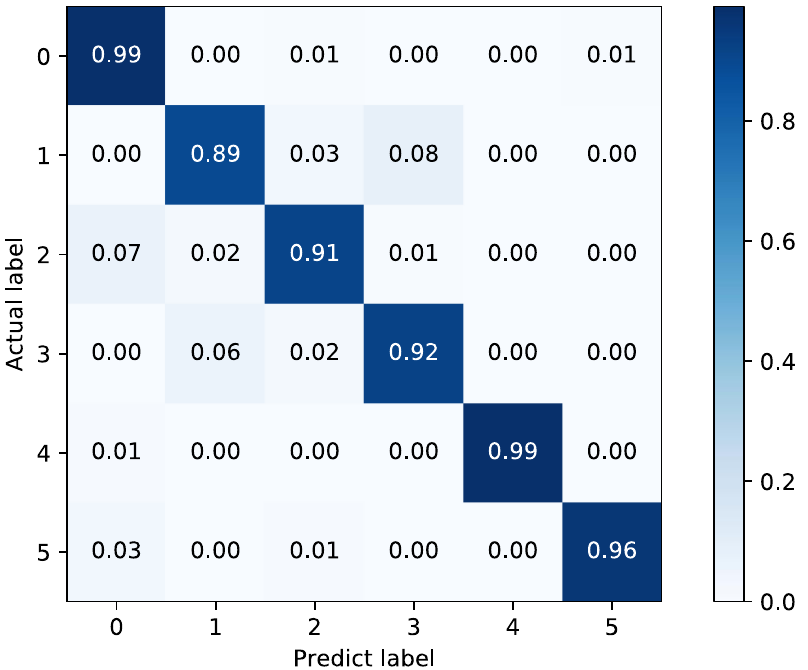
Figure 17. Confusion matrix of WPD + NN.